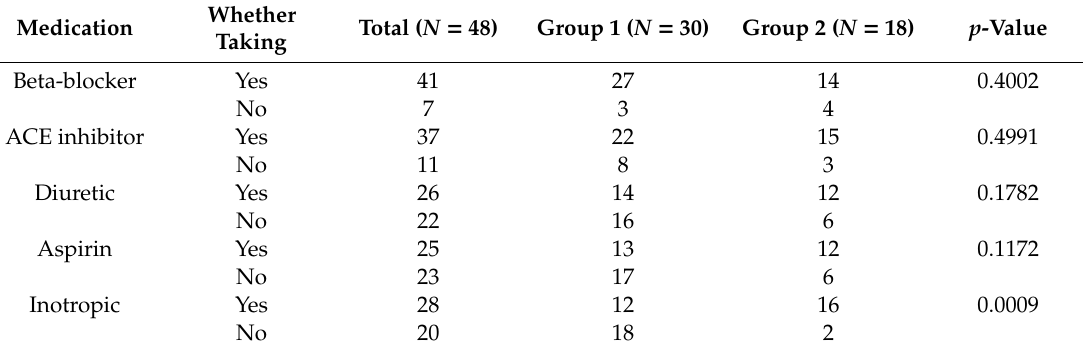
Table 5. Medication comparison between two groups with chi-square